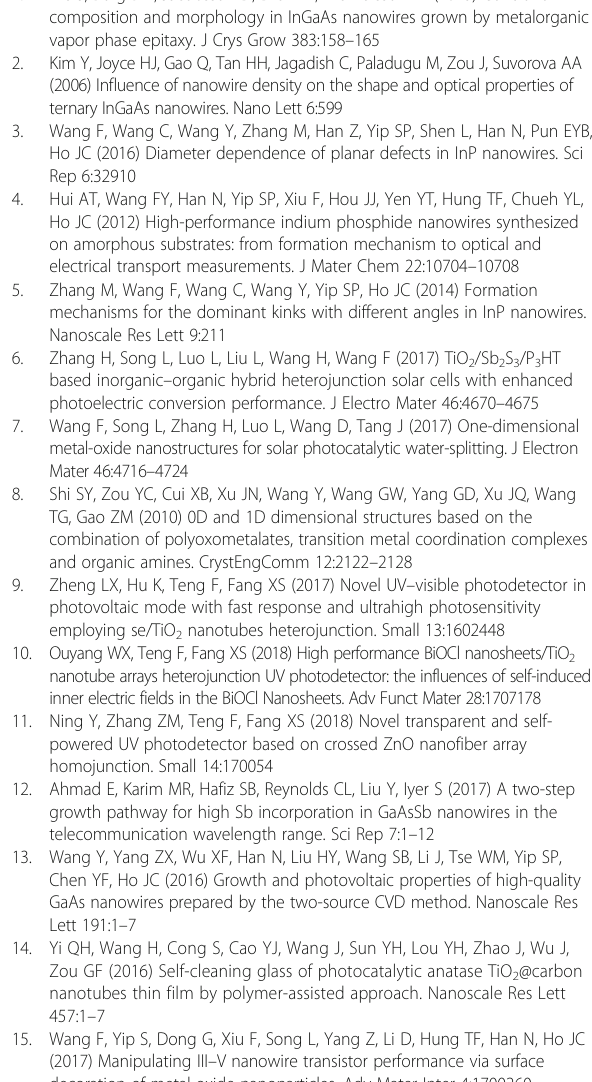
Additional file 1: Figure S1. The cross-section SEM images of the InGaAs NWs. (DOC 1615